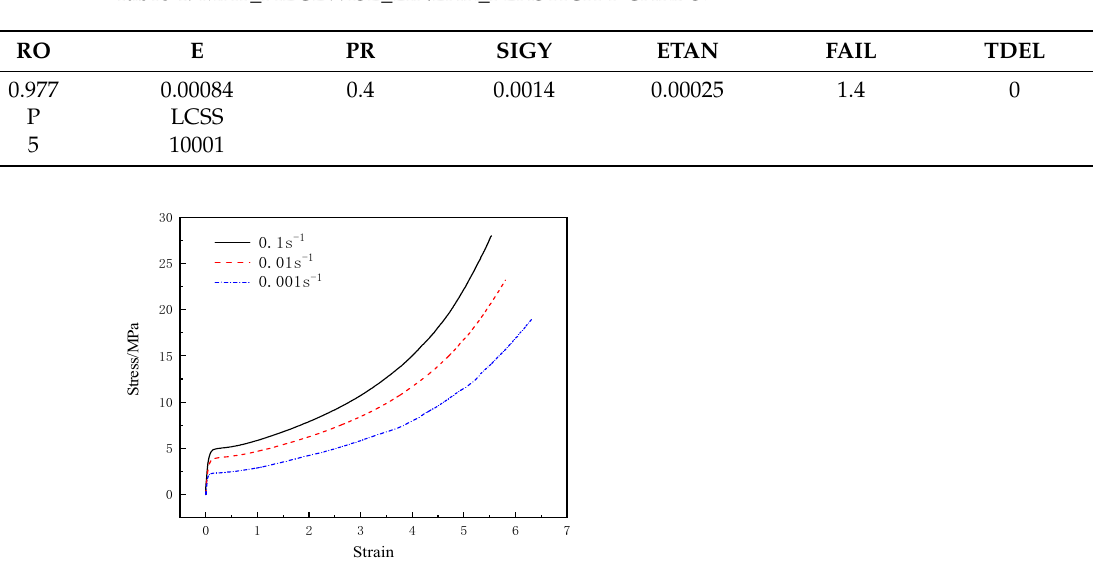
Figure 7. T26 polyurea true stress-strain curve at a high strain rate. The reinforcement model was MAT_PLASTIC_KINEMATIC [22]. It is an elastic-plas- tic material model with strain rate dependence and failure. The strain rate effect was de- scribed by the Cowper-Symonds model. The reinforcement simulation parameters are as shown in Table 6. Table 6. MAT_PLASTIC_KINEMATIC CARD. MID